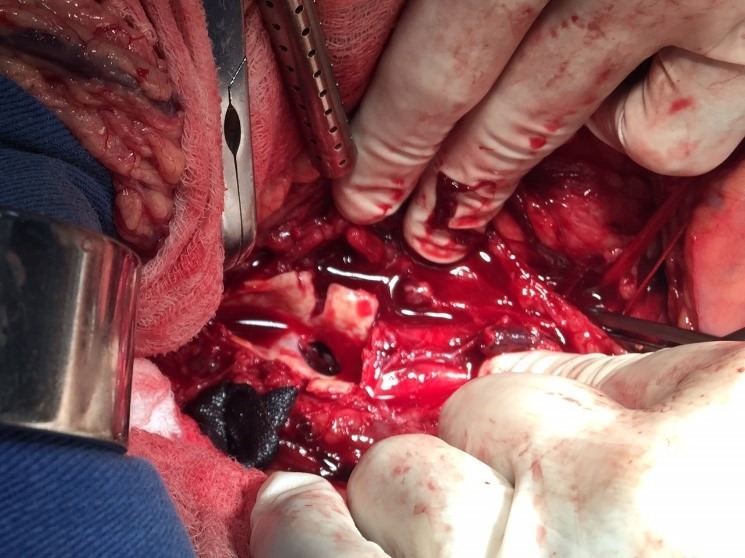
Ostium of the abdominal aortic pseudoaneurysm.